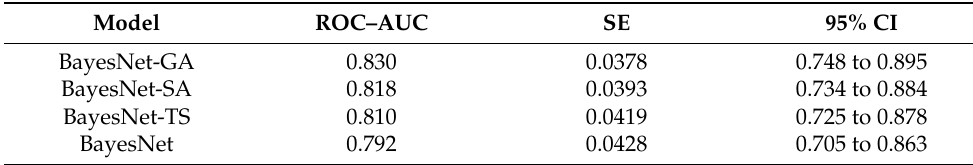
Figure 7. Graph of the ROC–AUC. Table 4. Results of the ROC–AUC for the hybrid